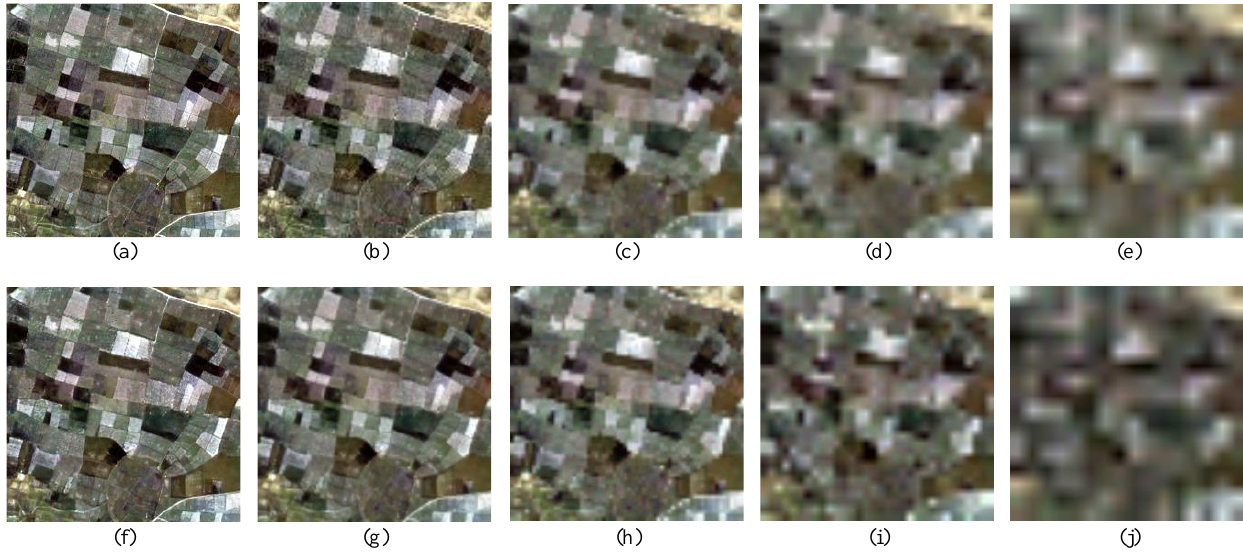
Figure 5. The reference image and pansharpening image are compared at different scales. The first line is the reference image for each scale, and the second line is pansharpening image for each scale. ( a – e ) are the reference images of the first to fifth layers respectively, and corresponding, ( f – j ) are the reconstructed images of the first to fifth layers